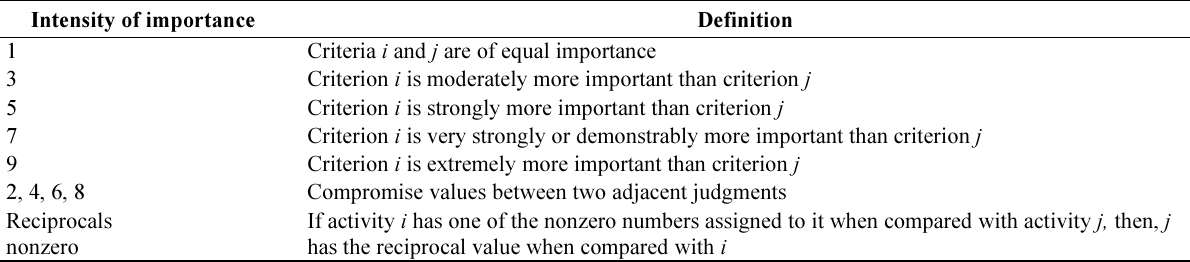
Table 7. Nine-point scale of a pairwise comparison (Saaty